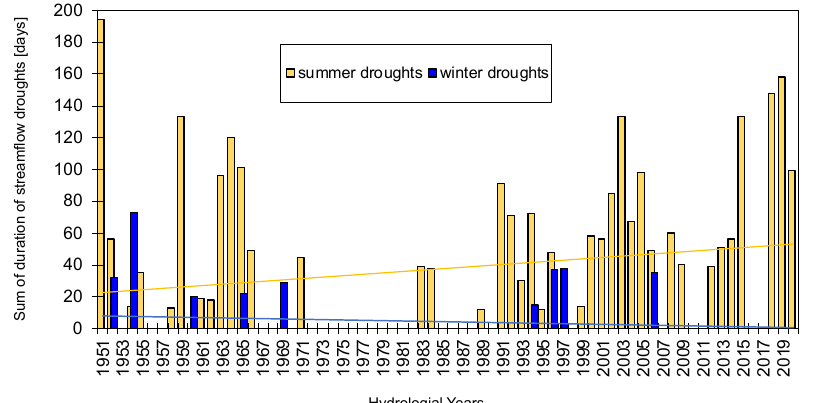
Figure 14. Duration of streamflow droughts in the hydrological years 1951–2020 in the Narewka River to Narewka gauging profile; Annotation: the streamflow drought of 1951 is considered to be a summer